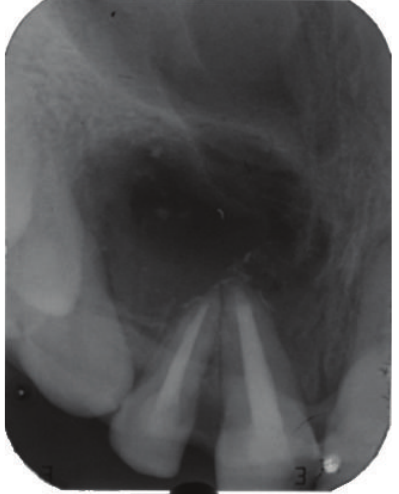
Figure 43: 1-month followup IOPA radiograph.